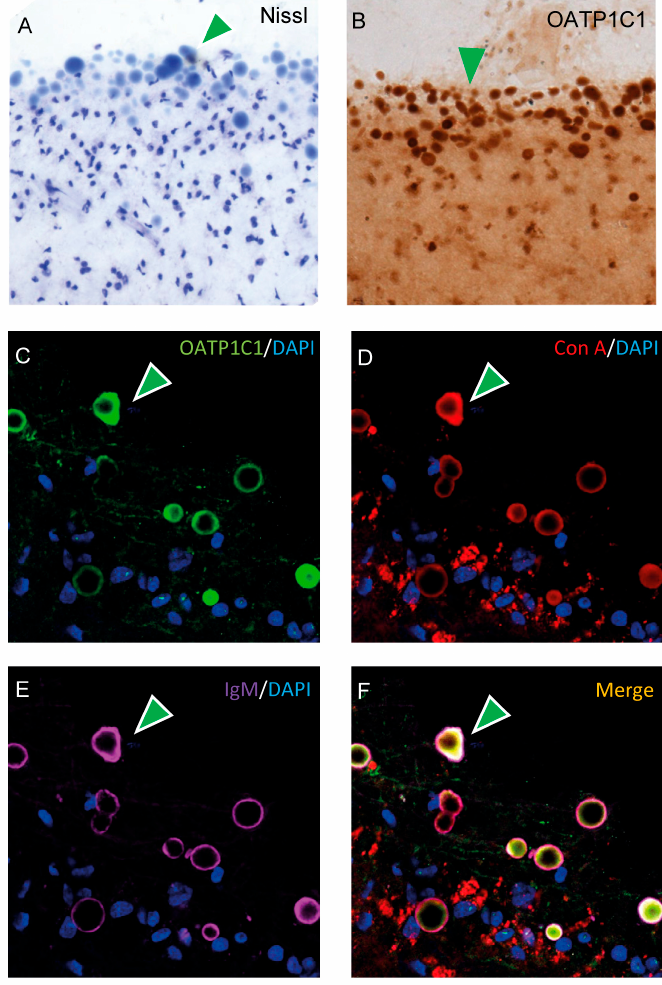
Figure 8. Expression of OATP1C1 in Corpora amylacea of the human motor cortex. ( A , B ) Representative brightfield photomicrographs of Nissl-stained ( A ) and OATP1C1 immunostained ( B ) sections in which green arrowheads point to numerous spherical vesicles located in the subpial region and layer I of the human motor cortex. ( C – F ) Confocal microscope images of triple labeling for OATP1C1 (green, C ), and the two Corpora amylacea markers Con A (red, D ) and IgM (purple, E ). The merged image ( F ) shows the total colocalization of the three markers (green arrowheads). Counterstaining with DAPI (blue) shows nuclei of all cells. Note that the vesicles do not contain a blue nucleus. Con A: Concanavalin A. Scale bar = 50 μ m ( A , B ), 40 μ m ( C – F ).